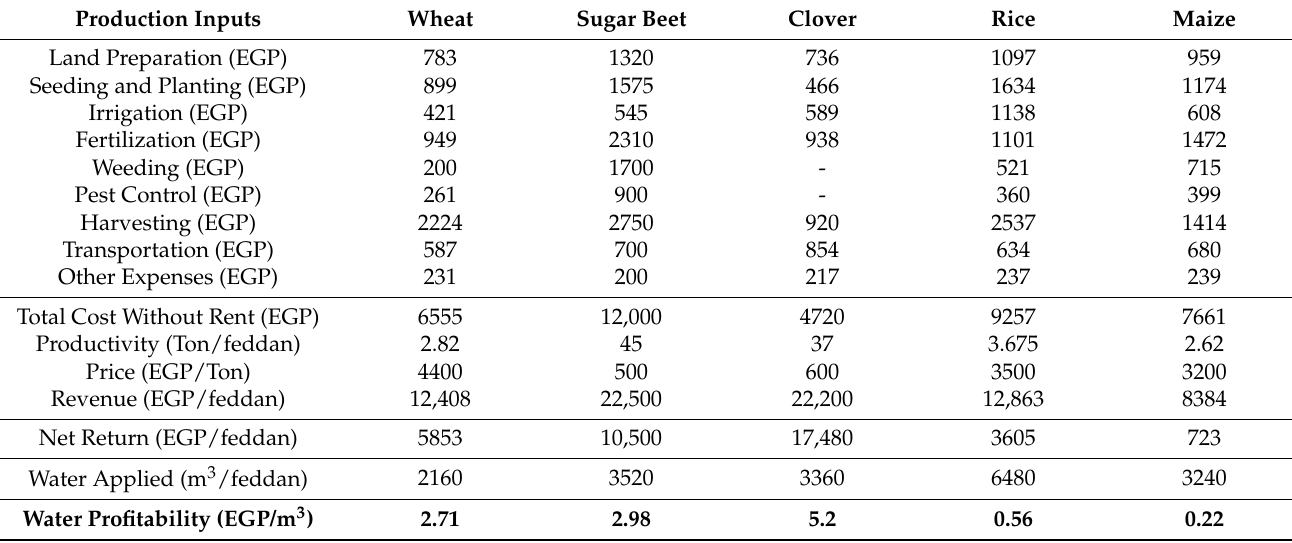
Table 2. Water profitability analysis for Sharkia governorate in 2020, source: field data collected from farmers and verified by